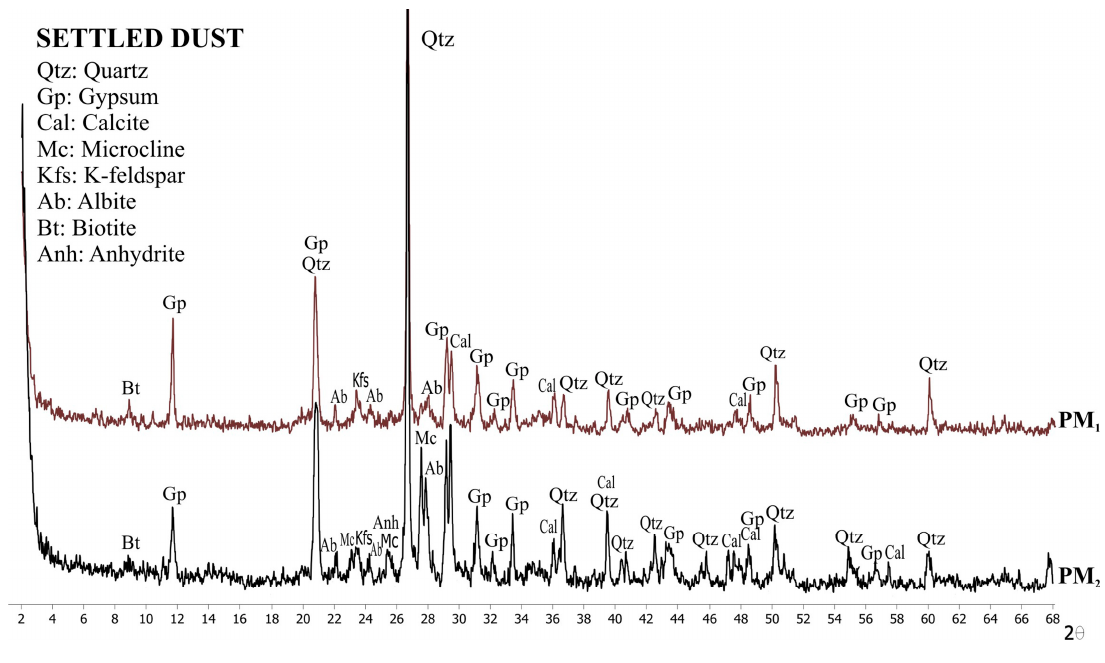
Figure 8. XRD patterns for the particulate matter taken from horizontal surfaces on the façade (PM 1 ) and surrounding wall (PM 2 ), showing the main constituent minerals. Table 3. Soluble ionic content in the particulate matter.